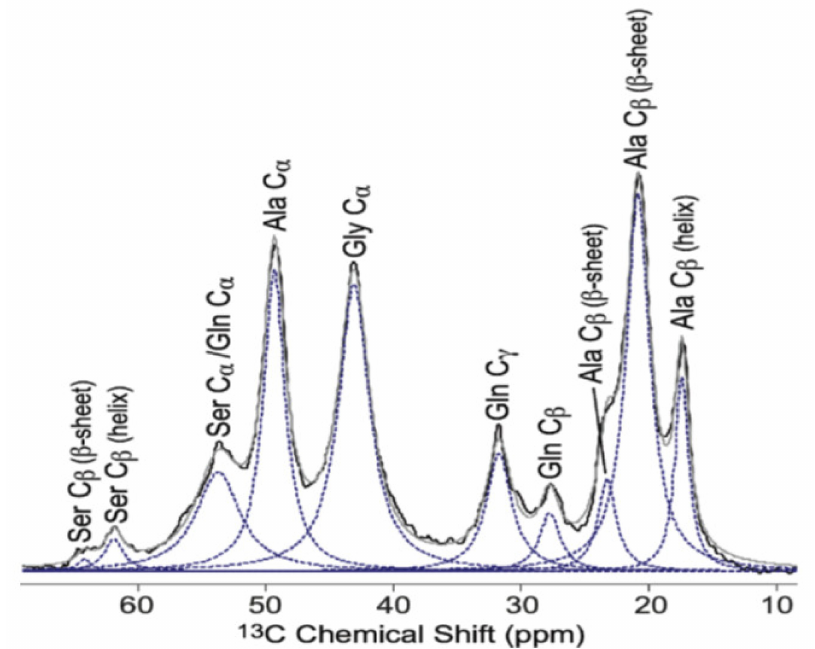
Figure 10. Expanded aliphatic region from fully relaxed 13 C directly detected MAS NMR spectrum of N. clavipes major ampullate silk in the hydrated state. The fraction of each peak was determined from the deconvolution shown by the broken lines